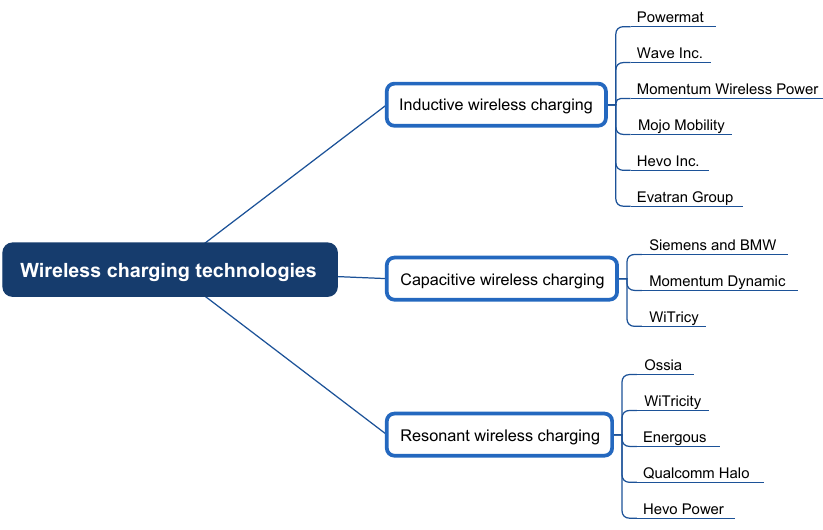
Figure 8. Taxonomy of wireless technologies based on the